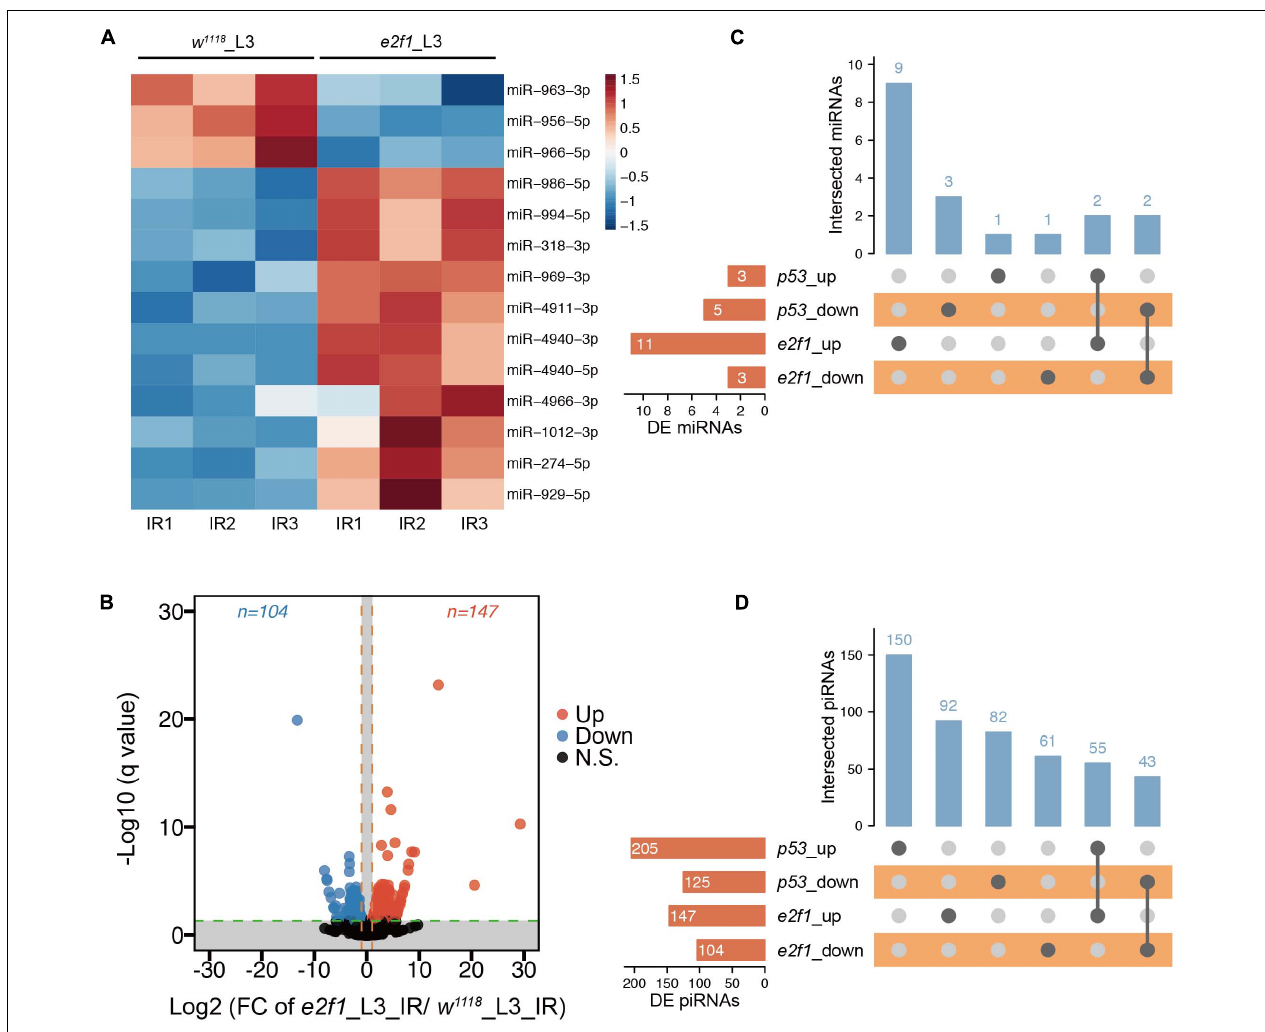
FIGURE 5 | DE miRNAs and piRNAs after X-ray irradiation in e2f1 mutant. (A) Heatmap of the DE miRNAs after DNA damage in e2f1 mutant L3. (B) UpSet plot depicting the number of DE miRNAs in response to DNA damage in p53 and e2f1 mutant L3. (C) Volcano plots of piRNAs differentially expressed between wild-type flies and e2f1 mutant L3 after X-ray irradiation. (D) UpSet plot depicting the number of DE piRNAs in response to DNA damage in p53 and e2f1 mutant